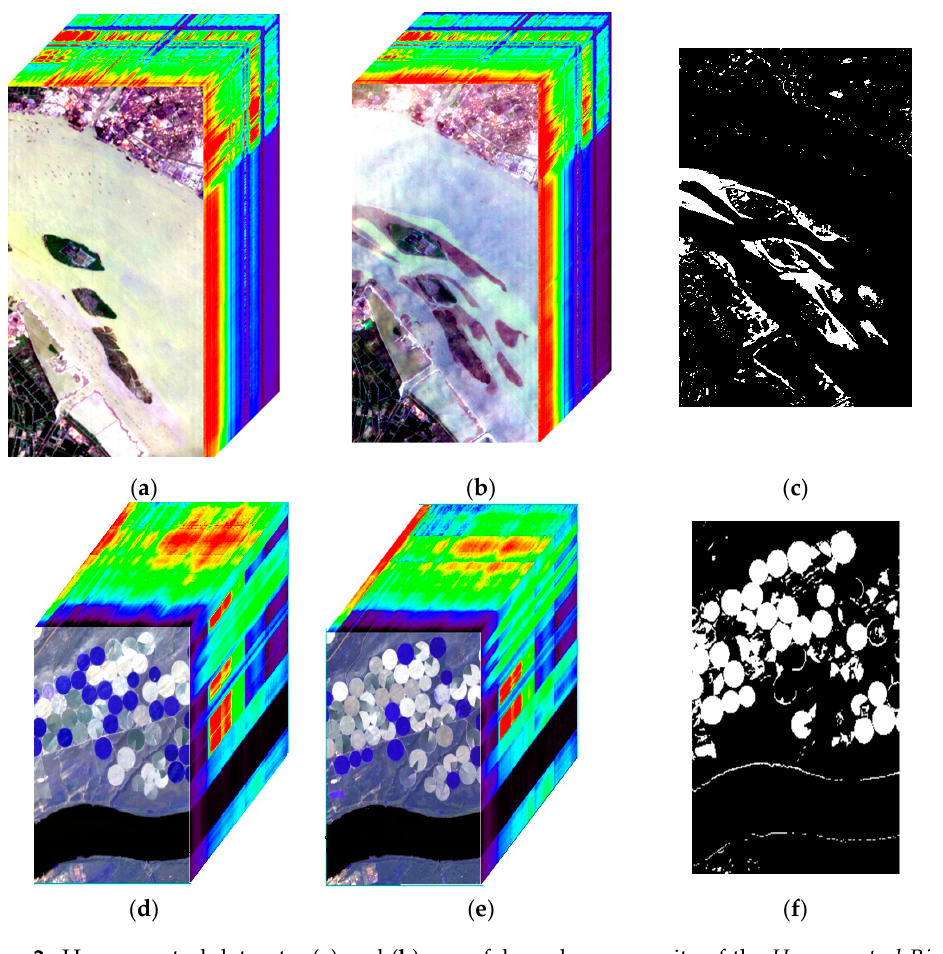
Figure 2. Hyperspectral datasets: ( a ) and ( b ) are a false-color composite of the Hyperspectral-River images acquired over a river in Jiangsu province, China on May 3, 2013, and December 31, 2013, respectively, and ( c ) is the corresponding binary ground truth data, which white and black colors indicate the change and no-change areas, respectively. ( d ) and ( e ) are a false-color composite of the Hyperspectral-Farmland images acquired over farmland in the USA on May 1, 2004, and May 8, 2007, respectively, and ( f ) is the corresponding ground truth data in binary format, which white and black colors indicate the change and no-change areas, respectively.